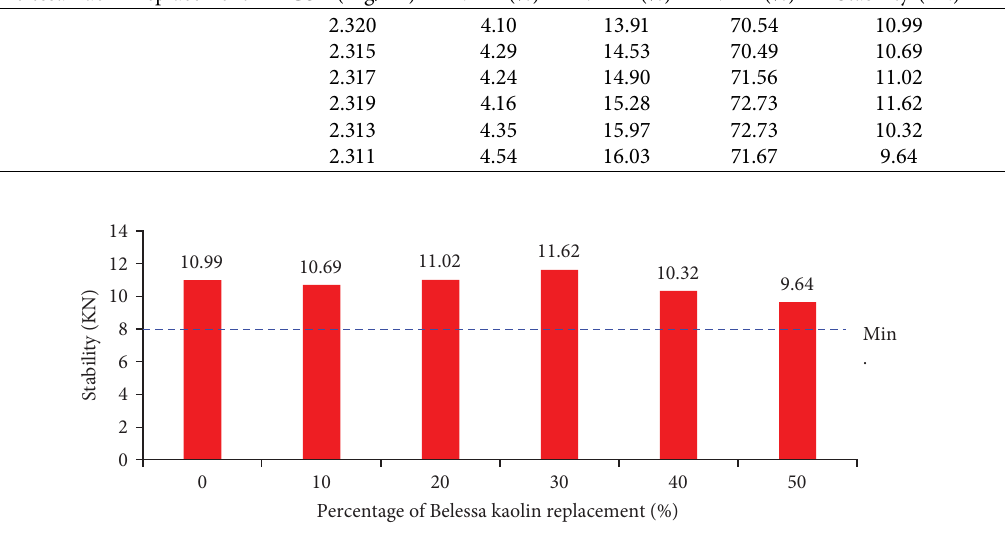
Figure 7: Relationship between stability and replacement rate of Belessa kaolin at OBC.